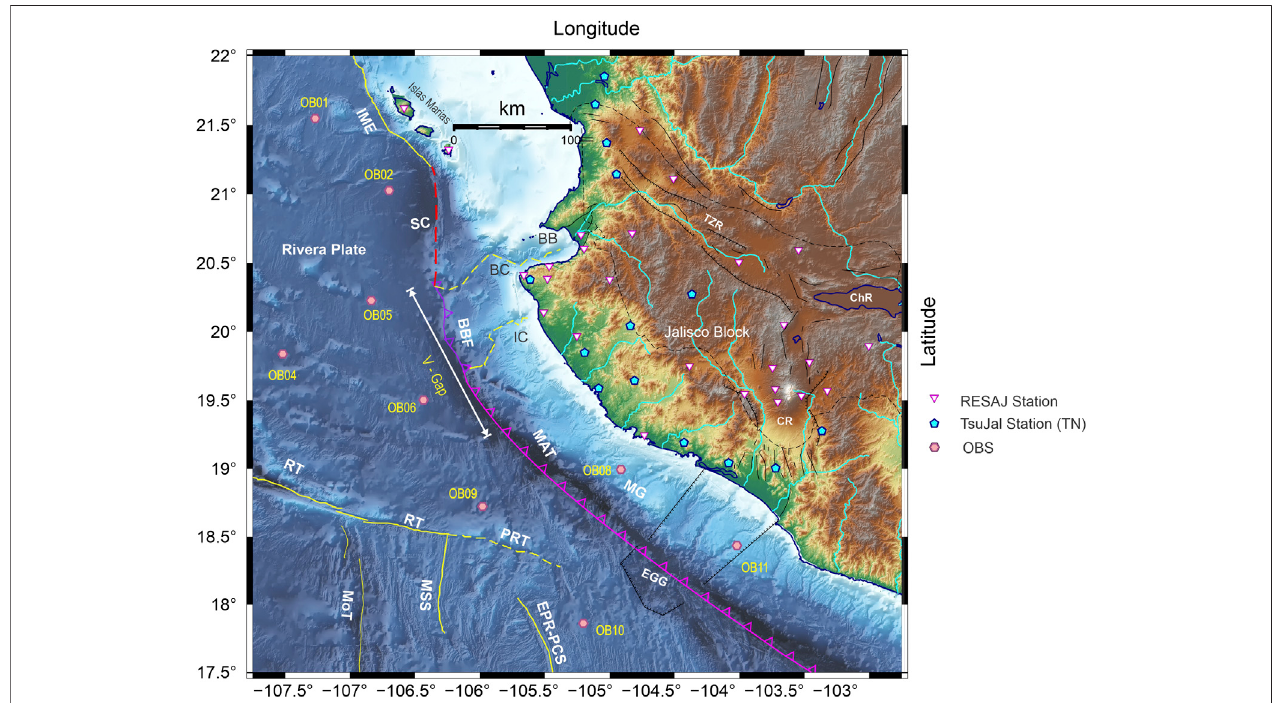
FIGURE 1 | Tectonic frame of the Paci fi c Mexican region. Abbreviations: BB, Bahía de Banderas; BBF, Bahía de Banderas fore-arc block (purple line); BC, BanderasCanyon(yellowdashedline);ChR,ChapalaRiftzone;CR,Colimariftzone;EGG,ElGordoGraben;EPR-PCS,EastPaci fi cRisePaci fi c-CocosSegment(yellow line); IC, Ipala Canyon (yellow dashed line); IME, Islas Marias Escarpment (yellow light line); MAT, Middle America Trench (red line); MG, Manzanillo Graben; MoT, MoctezumaTrough;MSS,MoctezumaSpreadingSegment;PRT,PaleoRiveraTransformfault(yellowdashedline)[afterPelaéz-Gaviriaetal.(2013);Núñez-Cornú et al.(2018)];RT,RiveraTransform (yellowline); SC,SierradeCleofas(pinkdashed line); TZR, Tepic-ZacoalcoRiftzone; V-Gap,VallartaSeismicGap.Seismic networks usedinthisstudy:whiteinvertedtrianglescorrespondtoRESAJpermanentstations;CyanpentagonsdenoteTsuJaltemporaryseismicstations(TN)andpinkhexagons are Ocean Bottom Seismometers